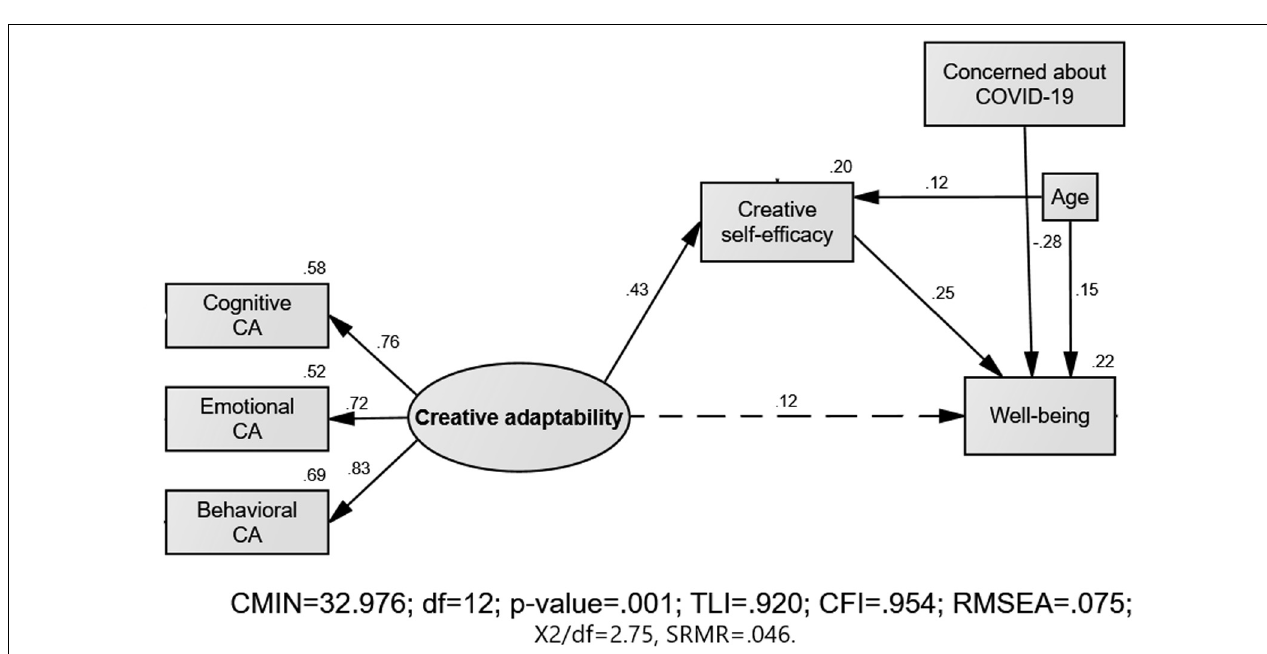
FIGURE 1 | Theorized mediation model. Standardized regression weights and multiple squared correlations are presented. Solid lines indicate path coefficients that are significantly different from zero, and the dashed path indicates non-significant path coefficient.